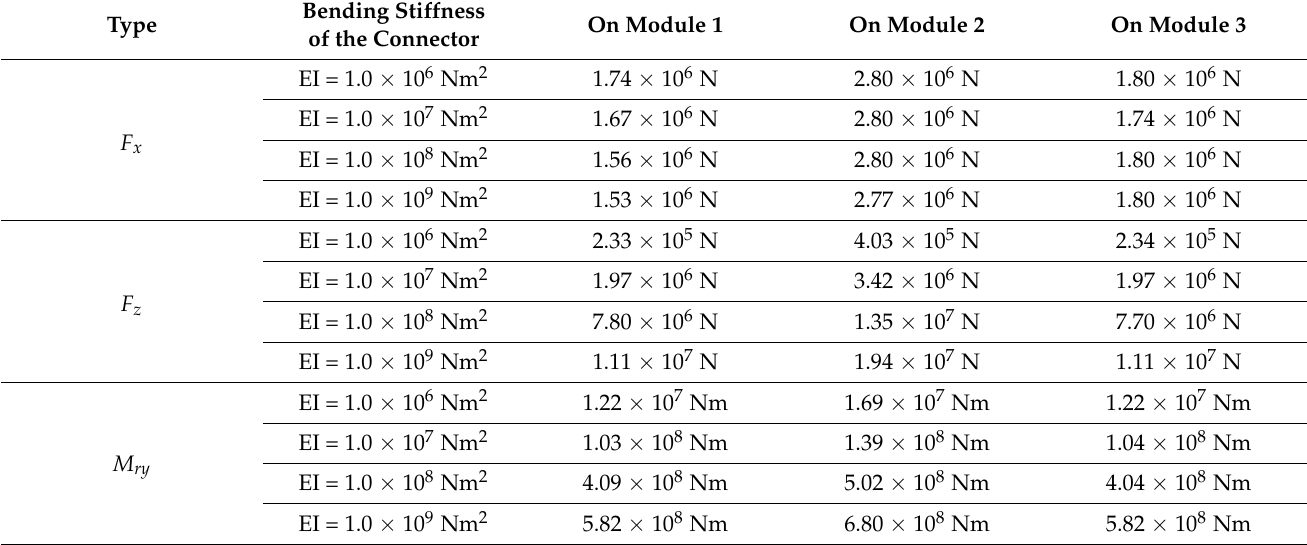
Figure 9. Constraint forces on each module under the action of connectors. Table 2. The peak value of the constraint force acting on each